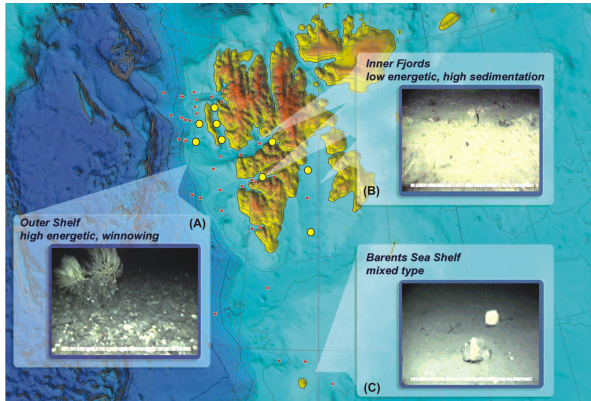
Fig. 3. Three types of sedimentary environment (modified after Winkelmann and Knies, 2005): (A) outer shelf, high energetic – no sedimentation; (B) inner fjords, low energetic – high sedimentation; (C) Barents Sea shelf, mixed type of medium energetic – low sed- imentation (based on interpretation of ROV pictures). Yellow dots indicate the studied core-top samples. The small red squares mark samples studied by Winkelmann and Knies